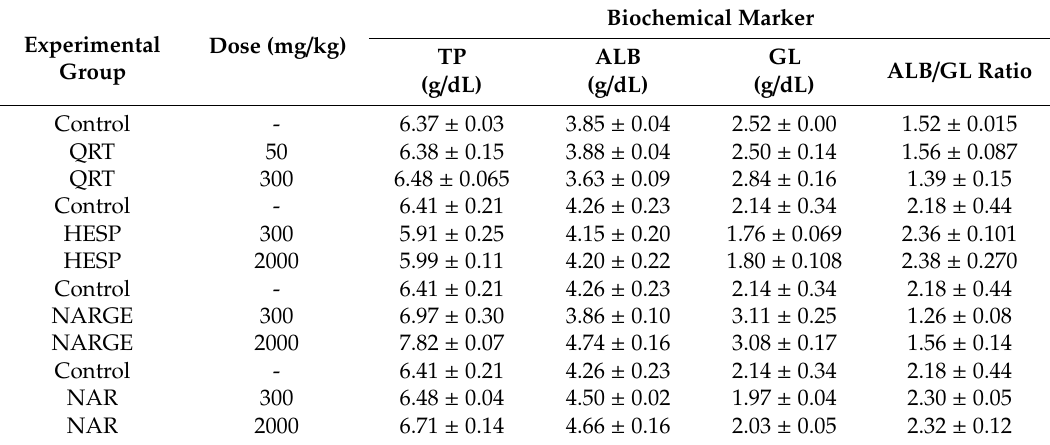
Table 2. Biochemical analysis: values and e ff ects after treatment with several doses of flavonoids.